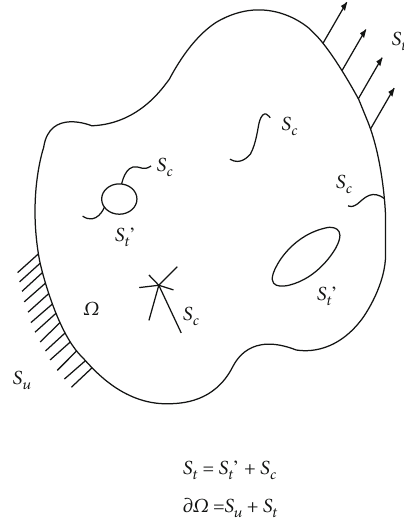
Figure 2: A defective solid with arbitrary cavities and